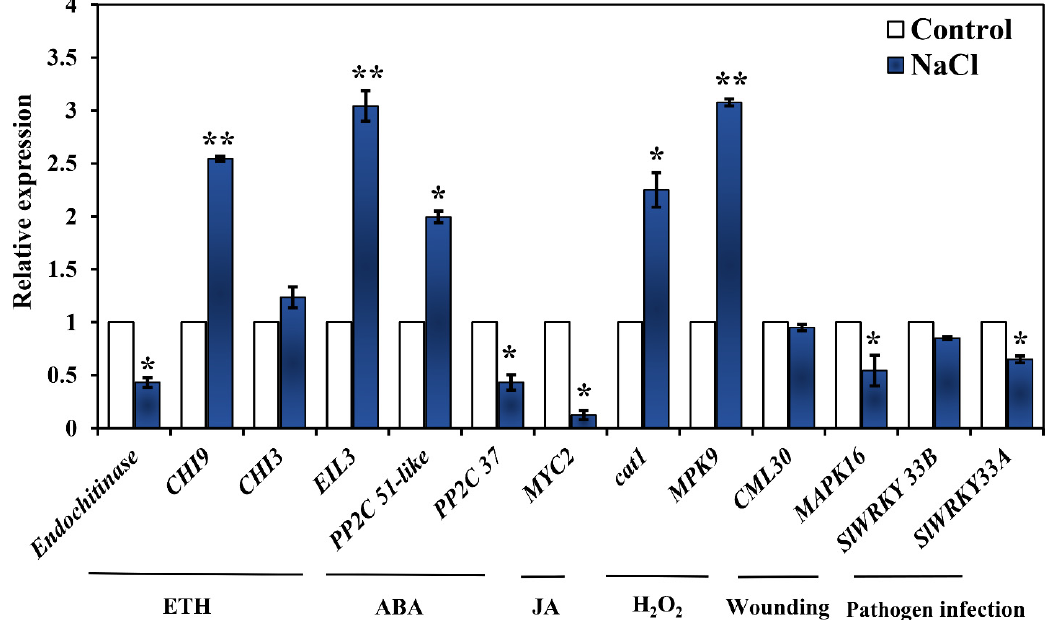
Figure 4. Quantitative real-time PCR analysis of the expression profiles of thirteen genes related to MAPK signal transduction during salt stress. The error line is the standard error. * and ** indicate significant differences (respectively, p < 0.05 and p < 0.01) according to Duncan’s multiple range test compared with the control.